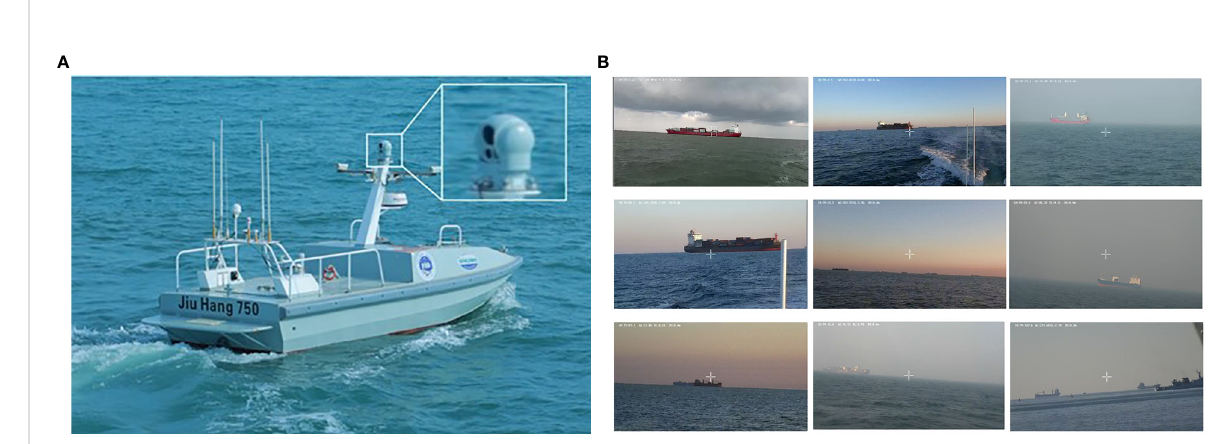
algorithm classi fi cation accuracy, and R was used to measure